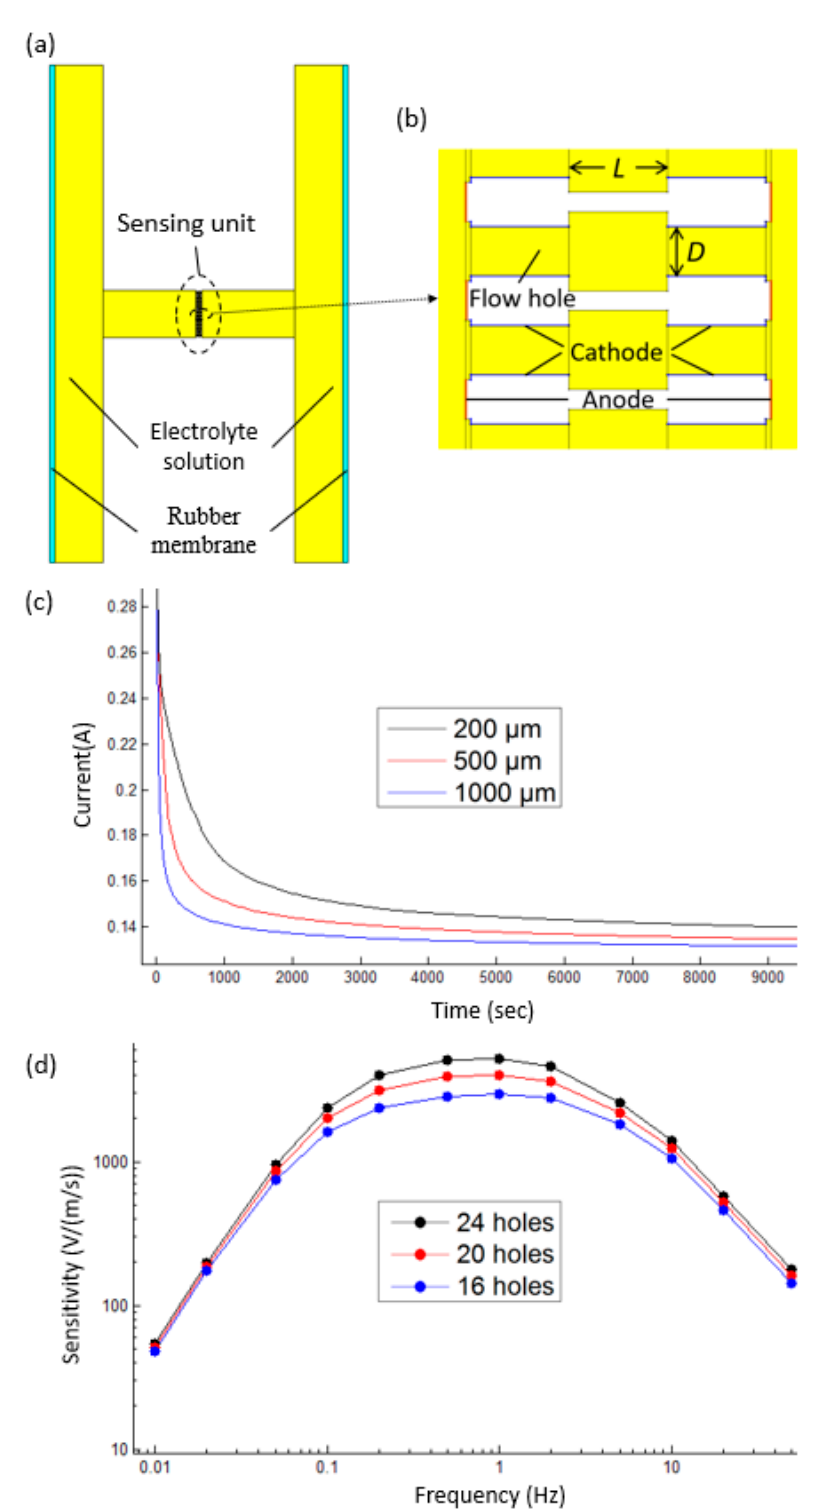
Figure 3. ( a ) Two-dimensional simulation model of the proposed electrochemical seismometer using COMSOL Multiphysics. ( b ) Enlarged view of the sensing unit with four electrodes integrated on one silicon–glass–silicon bonded wafer. ( c ) The output current curves of a single cathode of the electrochemical seismometer with a glass thickness of 200 μ m, 500 μ m and 1000 μ m when there is no vibration. ( d ) Simulation outputs (sensitivity vs. input vibration frequency) of the electrochemical seismometer with 24, 20 and 16 flow holes, showing the relationship between the sensitivity of the electrochemical seismometer and the number of flow holes in the sensing unit.